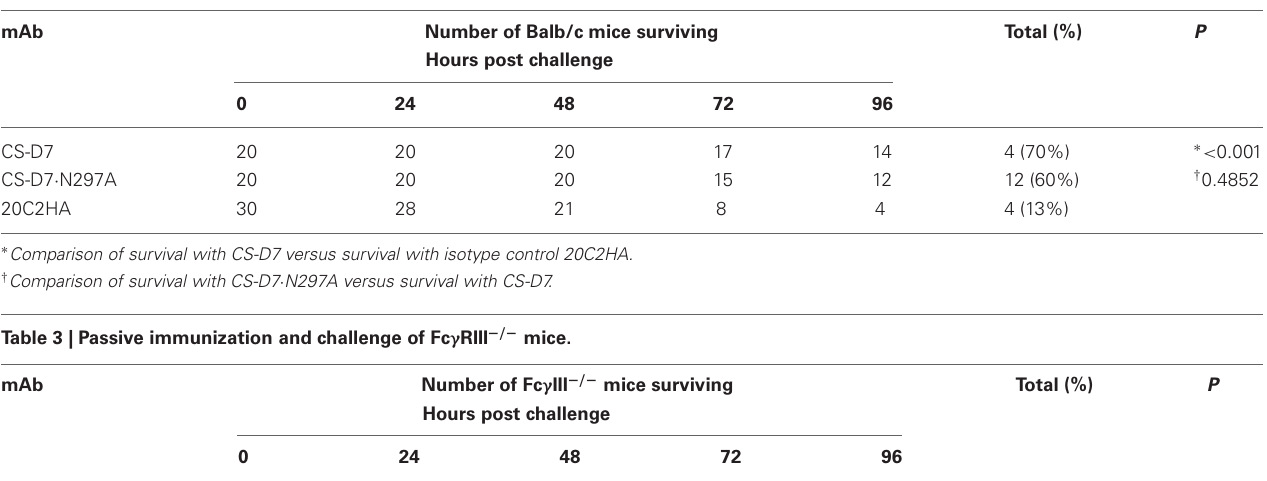
Table 2 | Comparison of mAb efficacy in the murine sepsis model. mAb